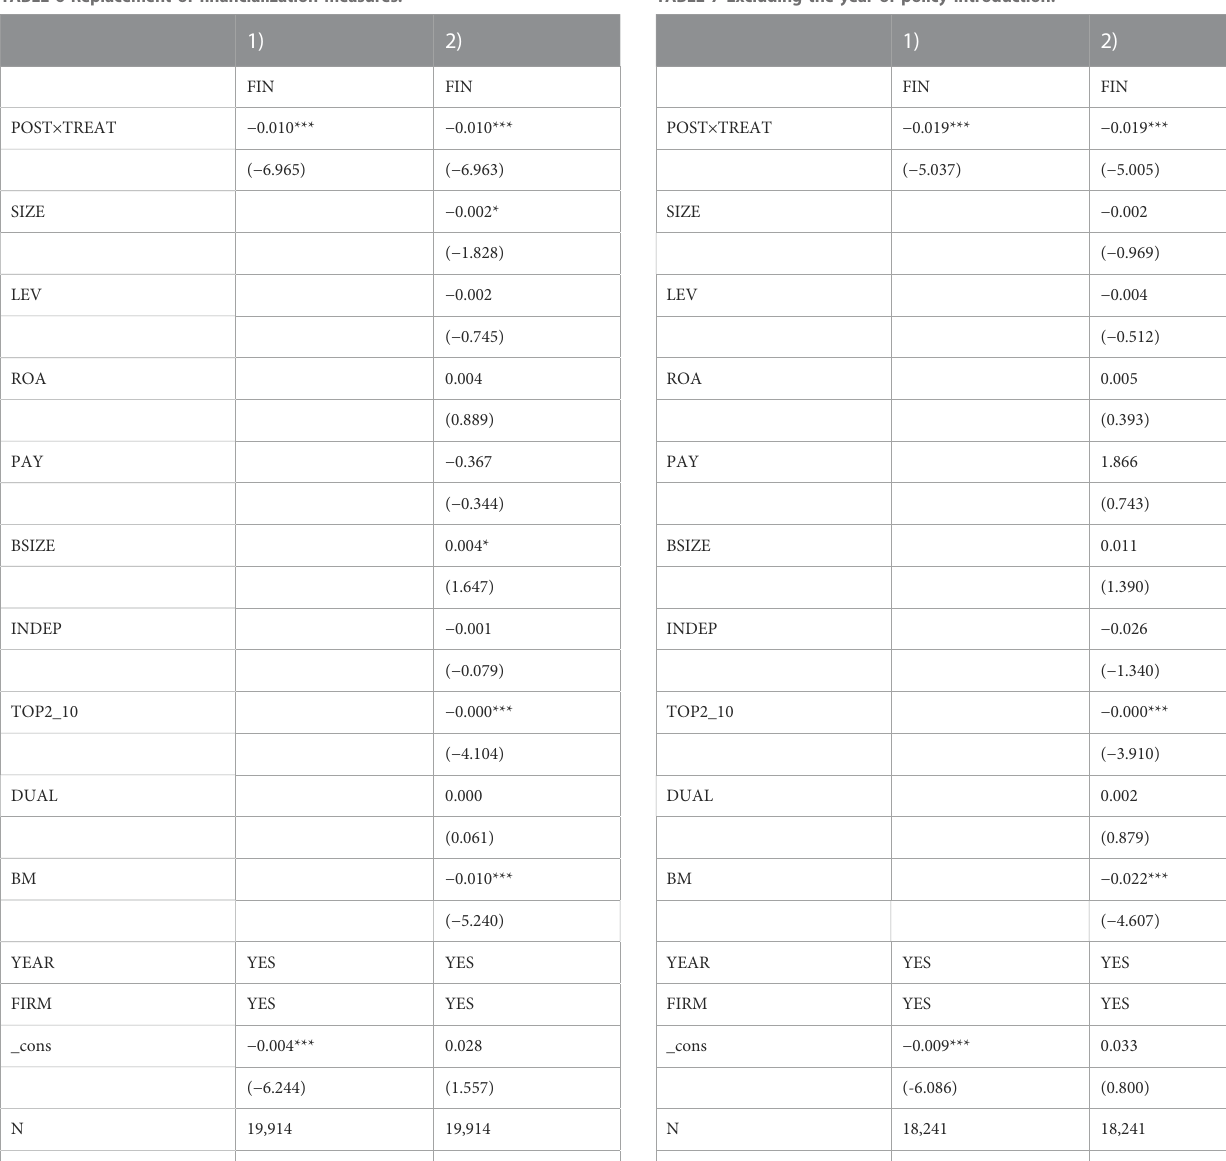
TABLE 6 Replacement of fi nancialization measures. TABLE 7 Excluding the year of policy